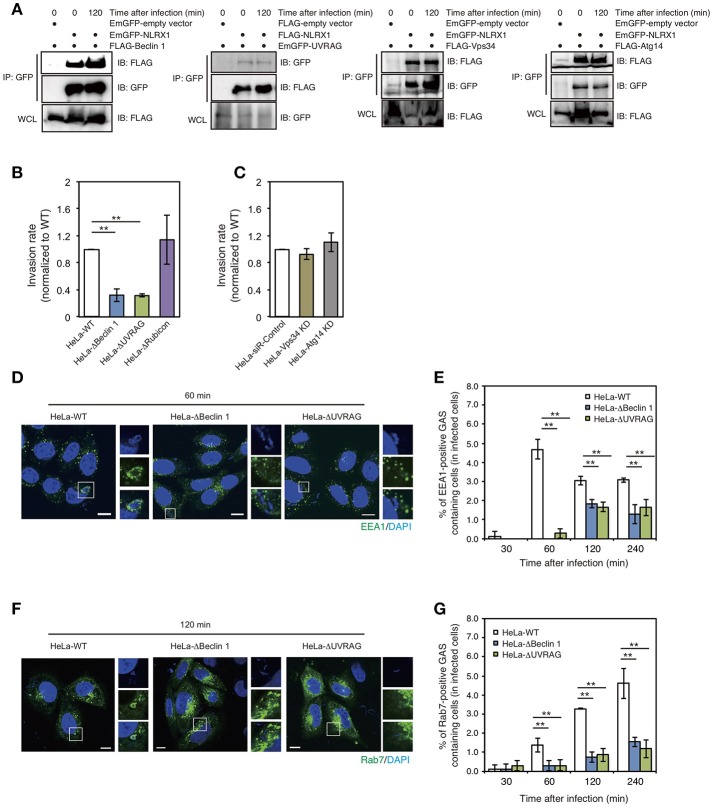
The NLRX1–Beclin 1–UVARAG complex regulates Group A Streptococcus (GAS) invasion by endocytosis. (A) NLRX1 interacts with the Beclin 1 complex. HeLa cells were transfected with EmGFP-empty vector or EmGFP-tagged Beclin 1 complex proteins (Beclin1, Vps34/PI3KC3, and Atg14) with FLAG-NLRX1. Similarly, cells were transfected with FLAG-empty vector or FLAG-tagged UVARG with EmGFP-NLRX1. Cell lysates were subjected to immunoprecipitations with anti-FLAG or—GFP (for UVRAG) antibody. The immunoprecipitated proteins and total cell lysates were analyzed by immunoblotting with anti-GFP or—FLAG (for UVRAG) antibody. (B,C) Invasion rate of GAS in HeLa wild-type, Beclin 1 KO, UVRAG KO, Rubicon KO, Vps34/PI3KC3 KD, and Atg14 KD cells. **P < 0.01. (D,F) Confocal microscopic images of EEA1 (D)- or Rab7 (F)-positive compartments containing GAS in HeLa wild-type, Beclin1, and UVRAG KO cells. Cells were transfected with EmGFP-Rab7, or immunostained with an anti-EEA1 antibody to visualize each endosomal marker. Cellular and bacterial DNA was stained with DAPI (blue). Scale bars, 10 μm. (E,G) The number of cells containing EEA1 (D)-, or Rab7 (F)-positive GAS were counted and presented as the percentage of the total number of GAS-infected cells. HeLa wild-type, Beclin 1, and UVRAG KO cells were infected with GAS for the indicated times. The data shown represent results from > 200 infected cells and indicate the mean value ± SD from three independent experiments. **P < 0.01.